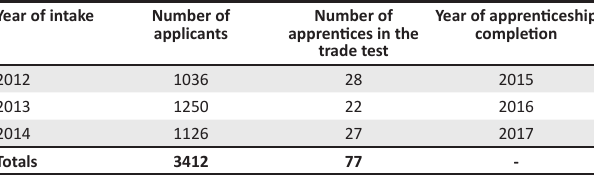
TABLE 1: Sample frame.